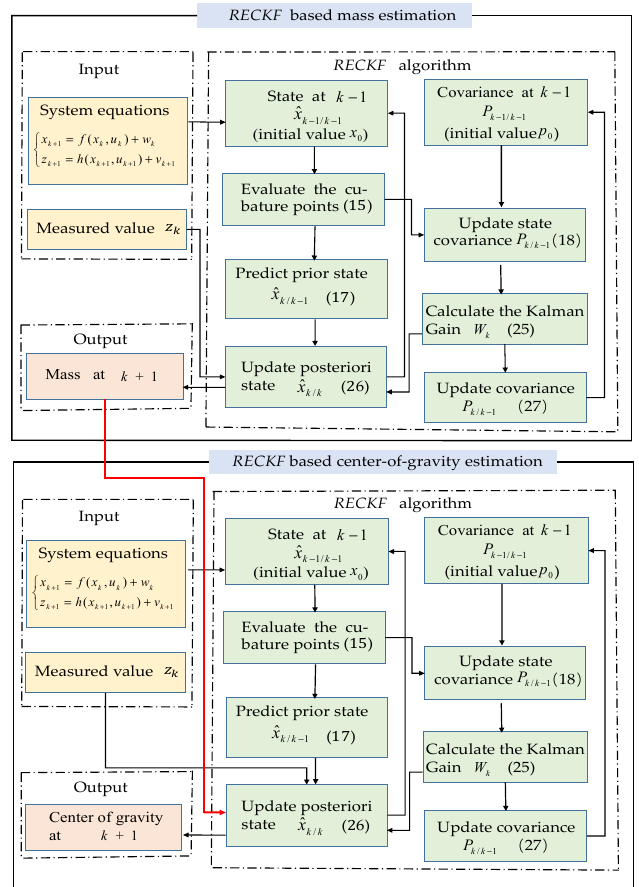
Figure 3. The flowchart of joint estimation.